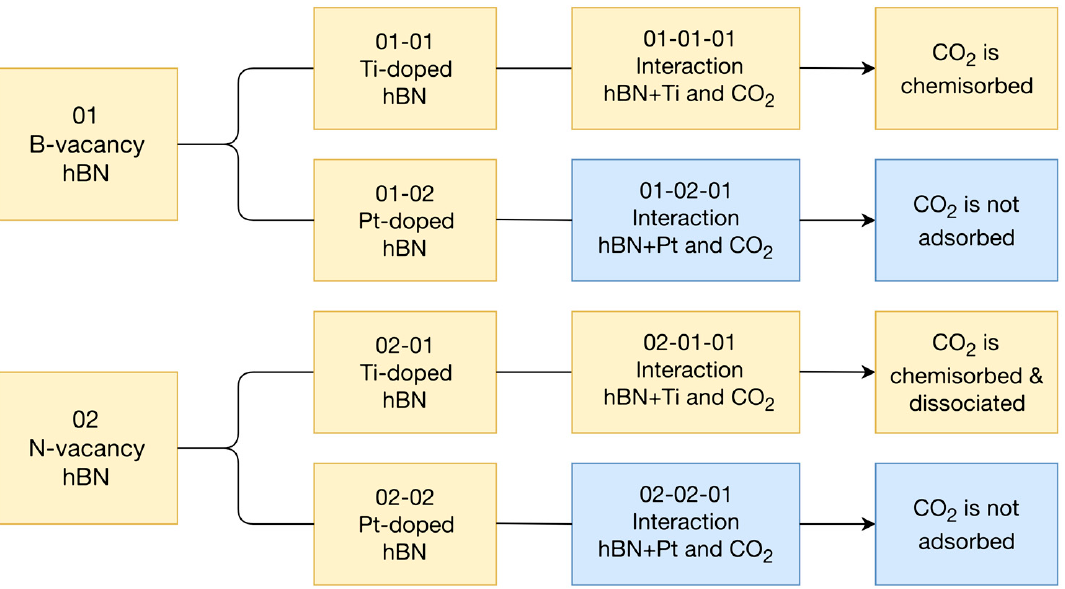
Figure 1. Diagram of the cases considered in this work. The interactions refer to FPMD calculations performed on [17]. This work builds from there to explore the optical properties of the resultant systems.